Question: Generate an informative caption for the figure above.
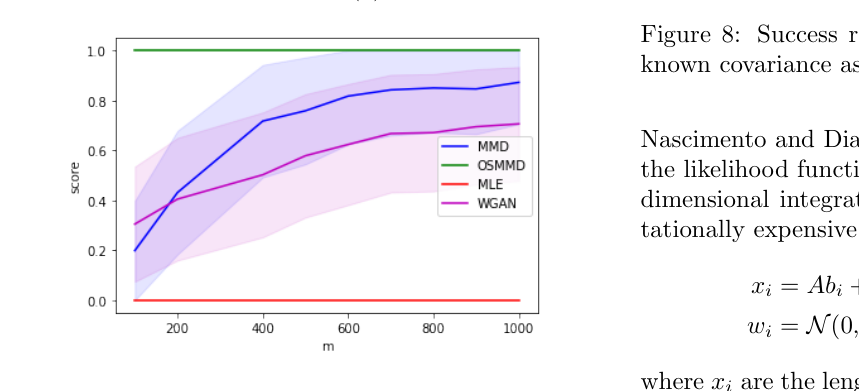
Answer: Success rate in a Gaussian model with un- known covariance as a function of m.